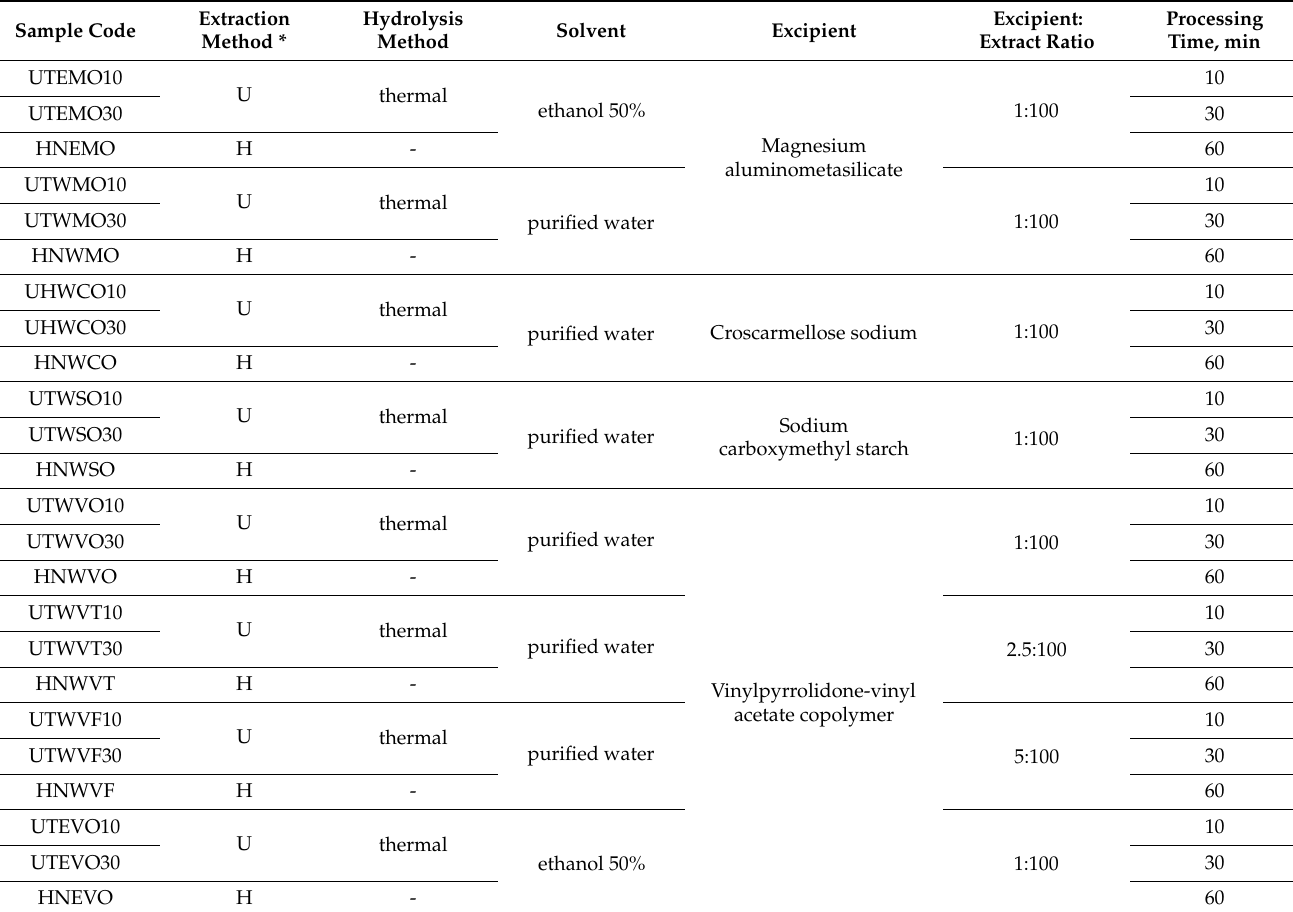
Table 2. Extraction conditions using excipients for the experiment.